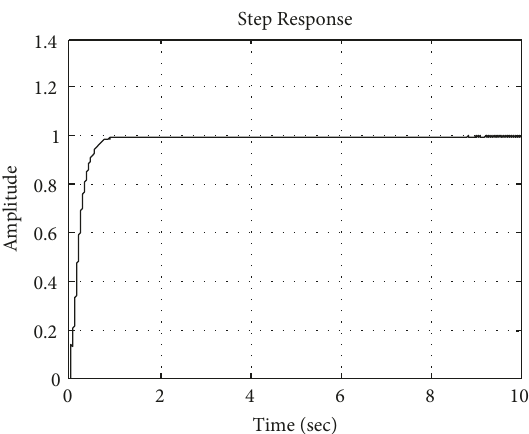
Figure 31: Response curve at 2 times β